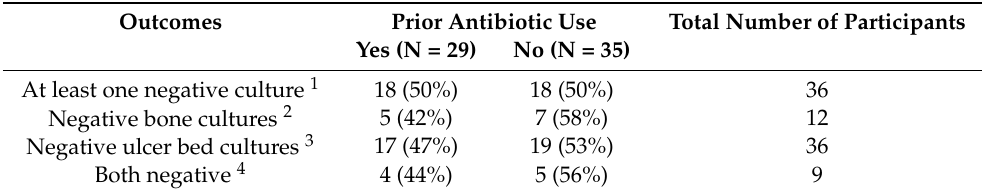
Table 2. Culture results.